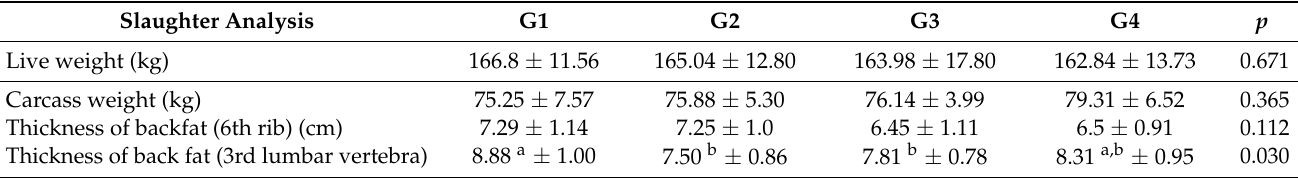
Live and carcass weight and back-fat thickness (mean ± standard deviation) of pigs from dietary experimental